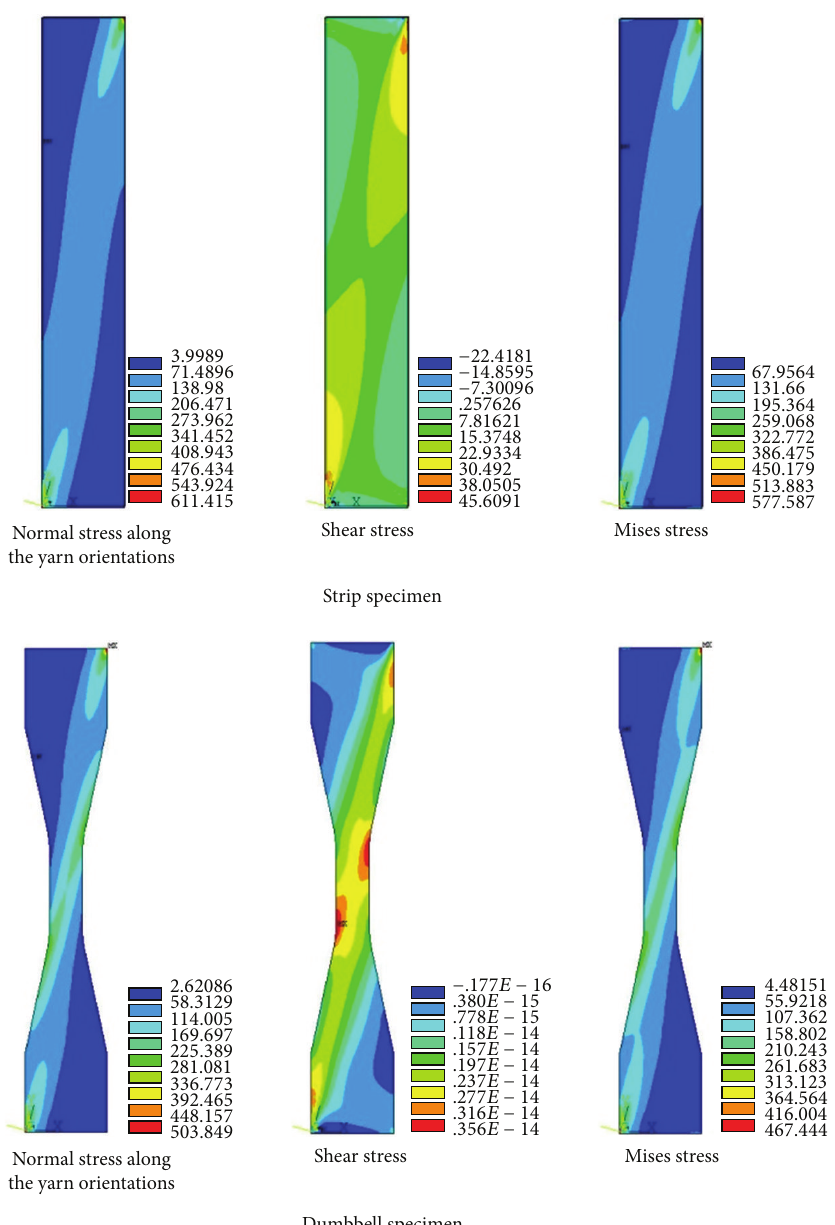
Figure 2: Stress distribution of 15-degree